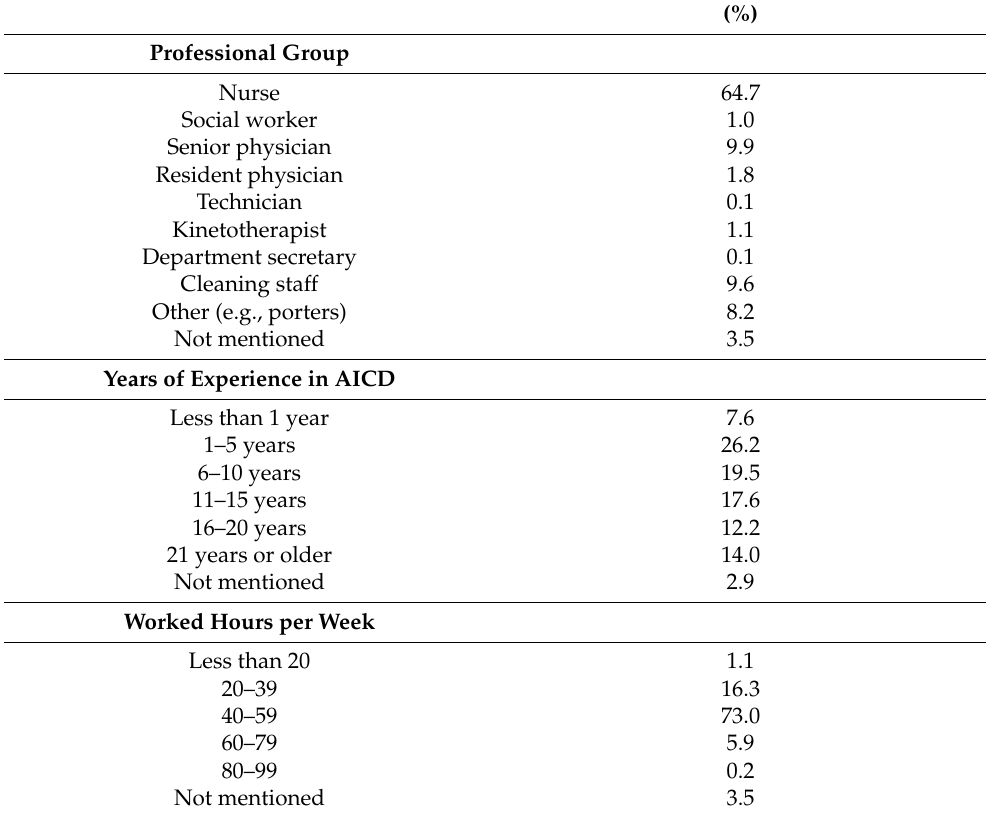
Table 1. Demographic data ( n = 927).